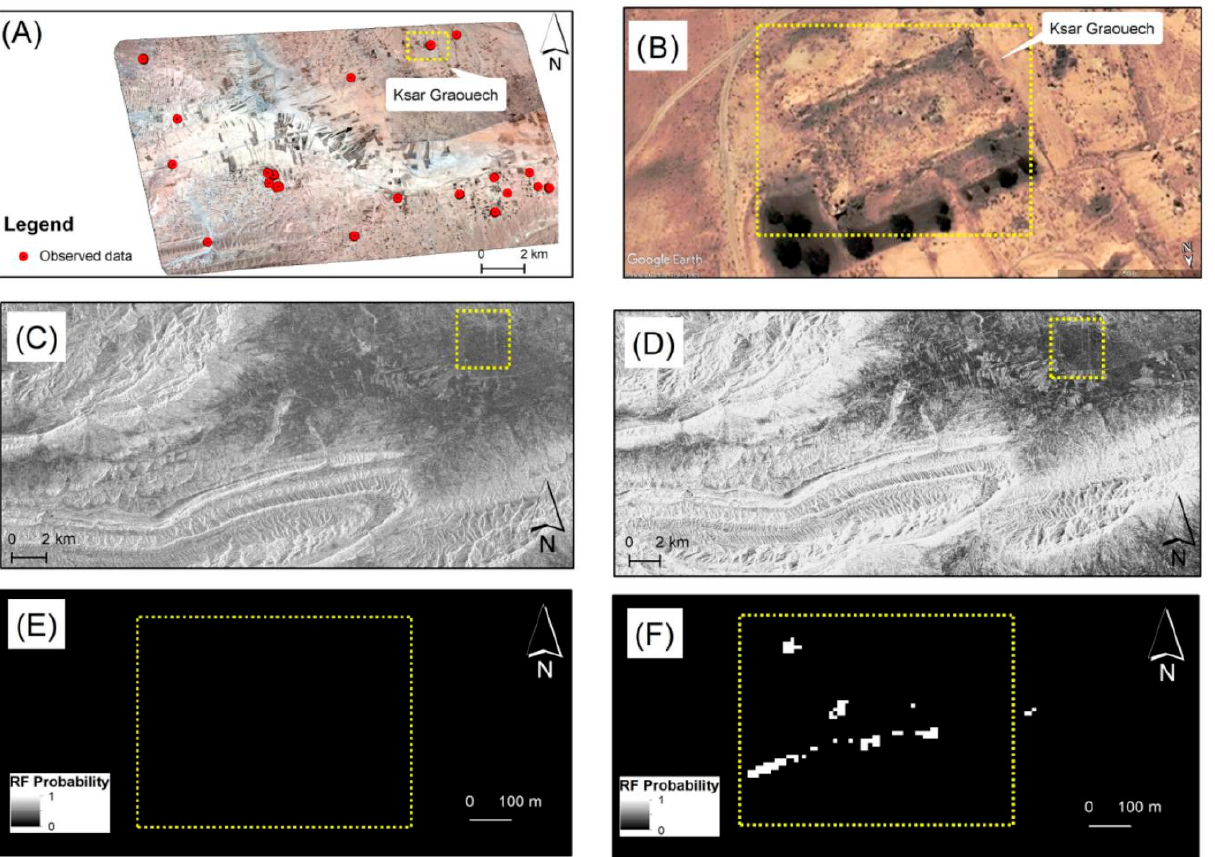
Figure 4. ( A ) The study area, showing the distribution of sites. ( B ) A Google Earth base map locating a well-preserved fort. ( C ) Dual Sentinel-1 band [VV, VH] in ascending mode. ( D ) Single Sentinel-1 band [VV] in ascending mode. Results of the RF classifier: ( E ) Visible high-resolution PB1 imagery without SAR images compared to the virtual absence of sites. ( F ) An example of SAR images combined with PB1 that detected a known fortified site used as a validation set; note that the white dots scattered through the region indicate high-RF probability sites.